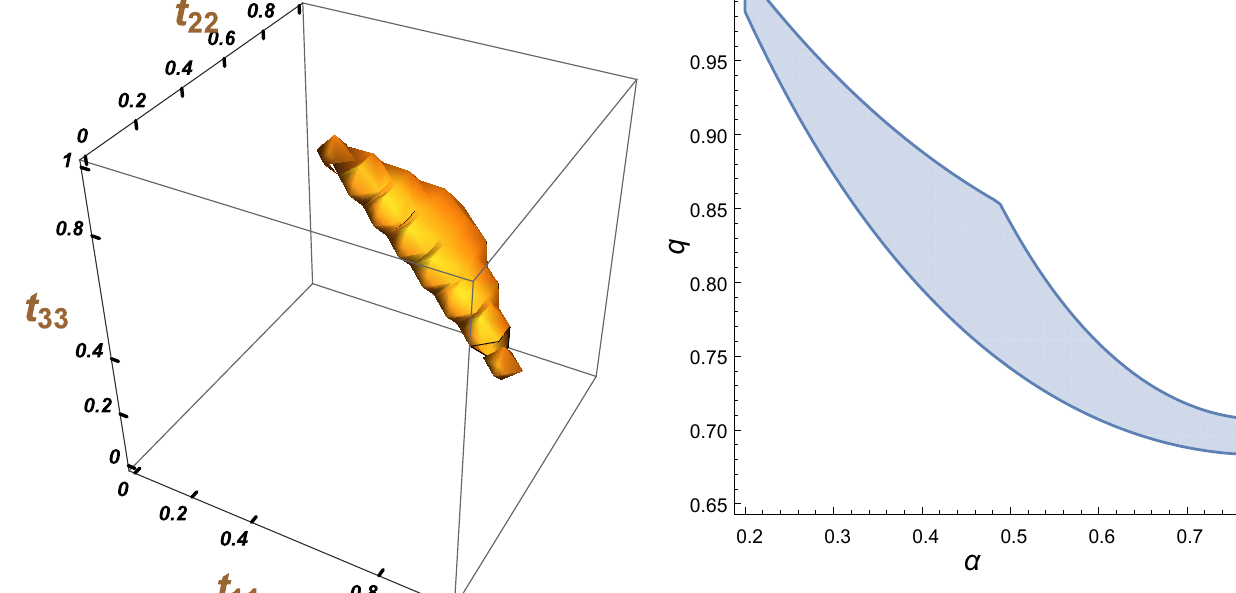
Figure 7: Shaded part of parameter space of family of states given by Eq. (29)) gives states useful in CJWR-based QKD protocol but useless in CHSH-based